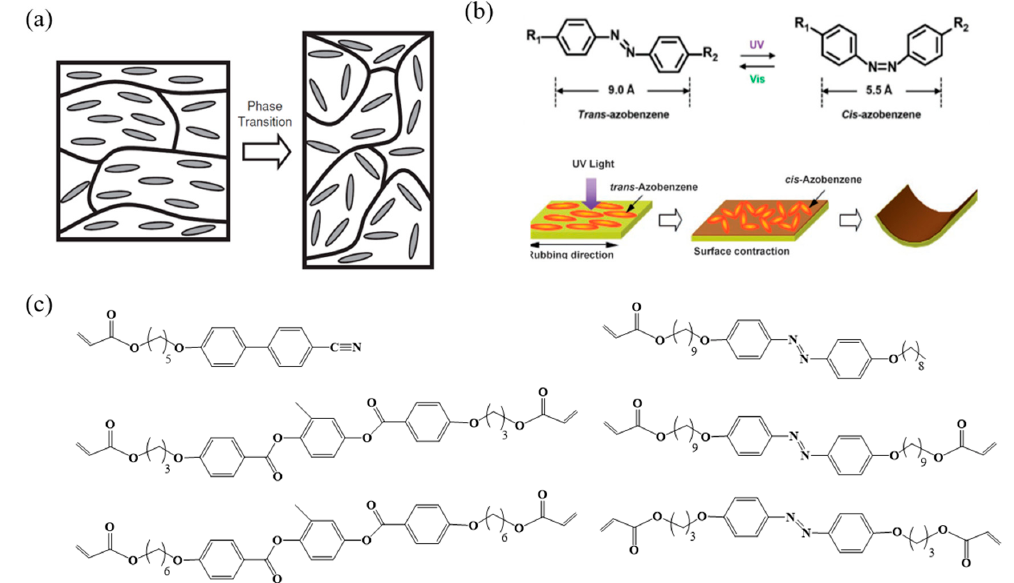
Figure 1. ( a ) Mechanisms of liquid crystal polymers (LCPs) shape change of the polymer chain suffering from anisotropic deformation to its coiled conformation above the nematic-to-isotropic phase transition. Reproduced with permission from [2]. Copyright © 2010 WILEY-VCH. ( b ) Mechanisms of the photoinduced bending behavior in the azobenzene-containing LCPs caused by a trans–cis photochemical phase transition in the surface. Reproduced with permission from [13].